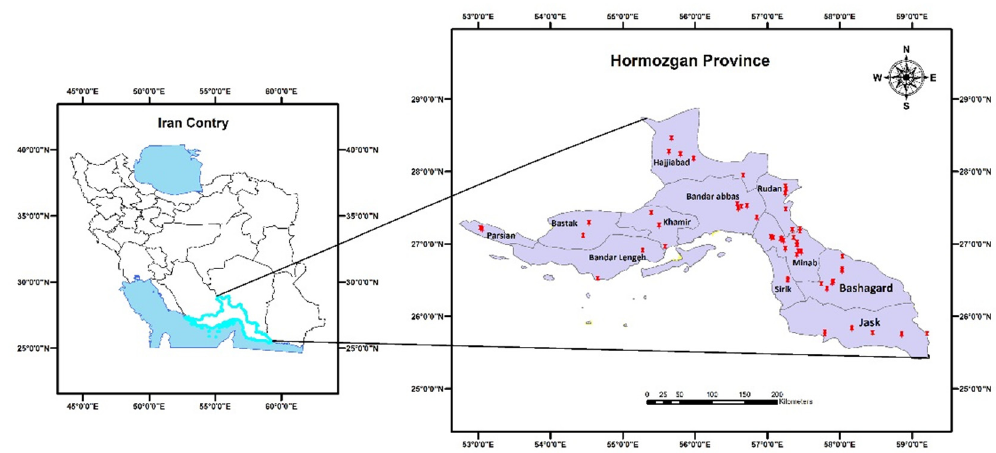
Figure 1. Location of Iran in the world and Hormozgan province in Iran.